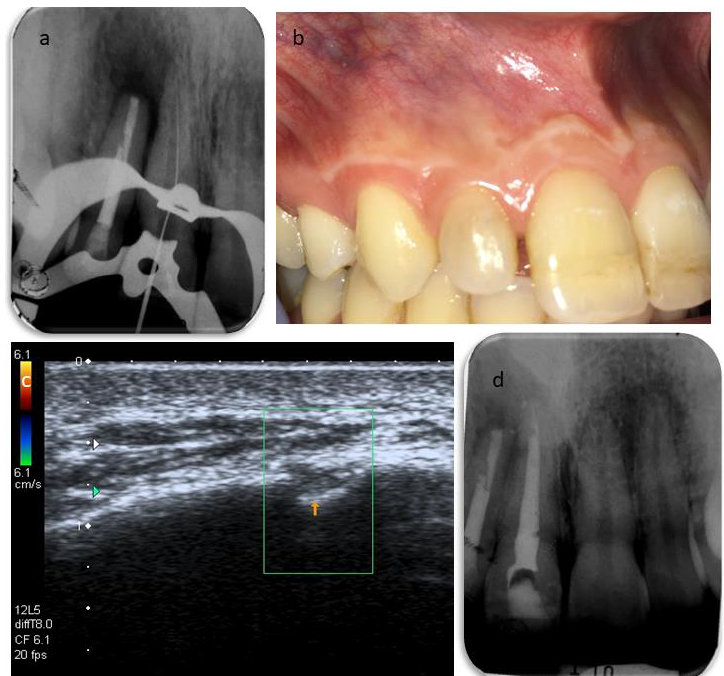
Figure 7. ( a ) Root canal treatment of tooth 1.1. ( b ) Clinical examination at one week after the root canal treatment, showing the disappearance of the stoma. ( c ) Ultrasound examination with the addition of the color Doppler showing the disappearance of the sinus tract and the vascular signal within the periapical lesion. ( d ) Post-operative periapical radiograph.